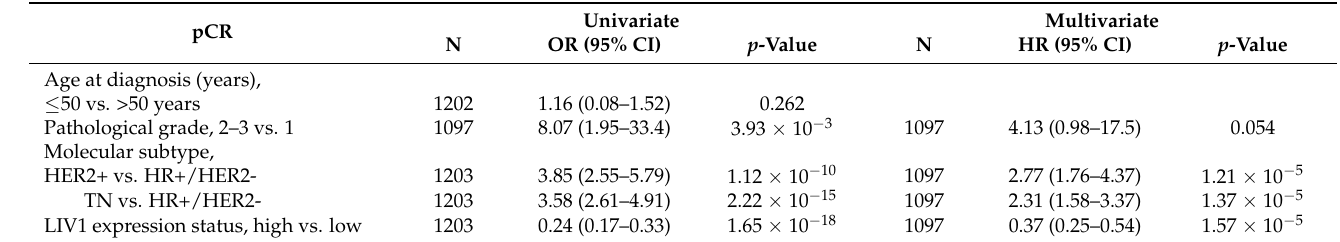
Table 4. Univariate and multivariate analyses for pCR in the whole